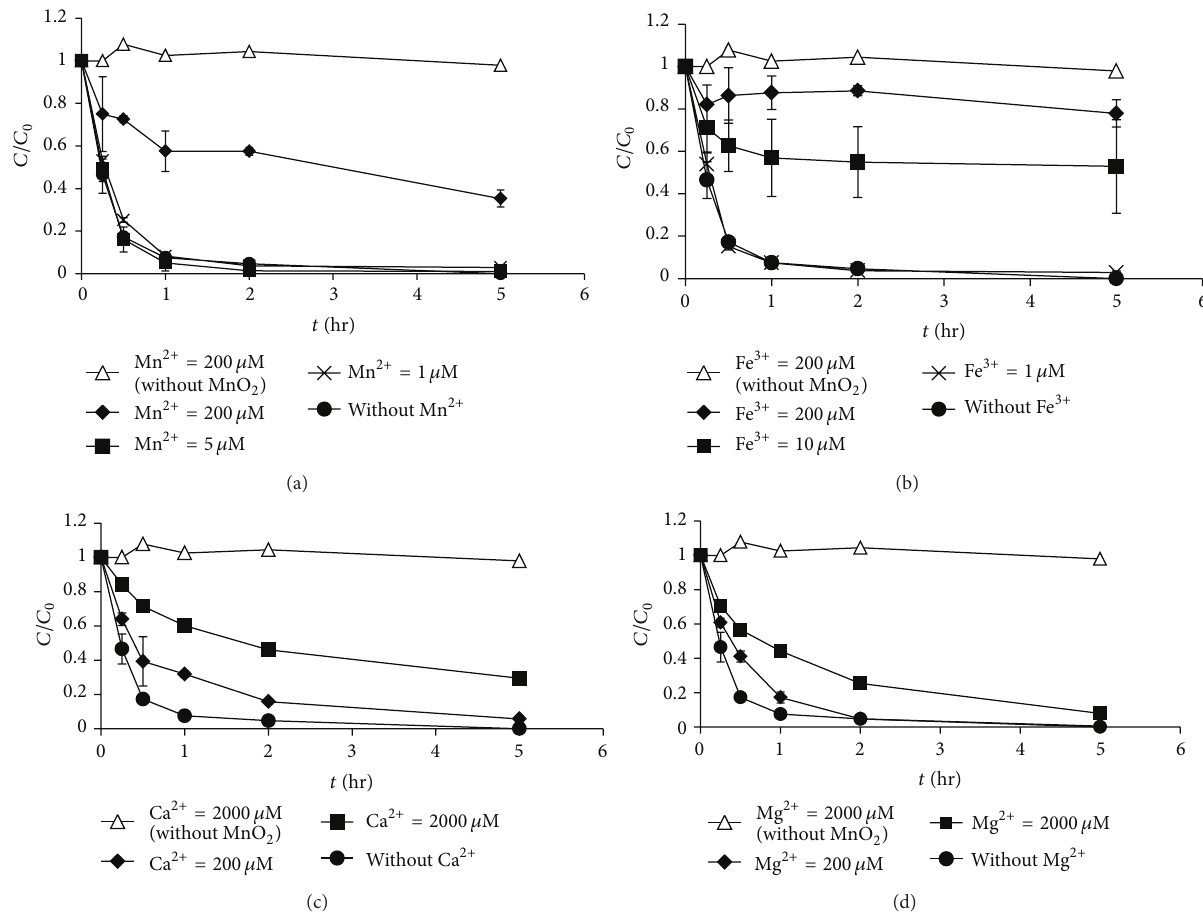
Figure 5: Effect of metal ions on the oxidation of morphine by MnO 2 : (a) Mn 2+ , (b) Fe 3+ , (c) Ca 2+ , and (d) Mg 2+ (MnO 2 loading = 100 𝜇 g/L, initial morphine concentration = 100 𝜇 g/L, pH = 7, and ionic strength =